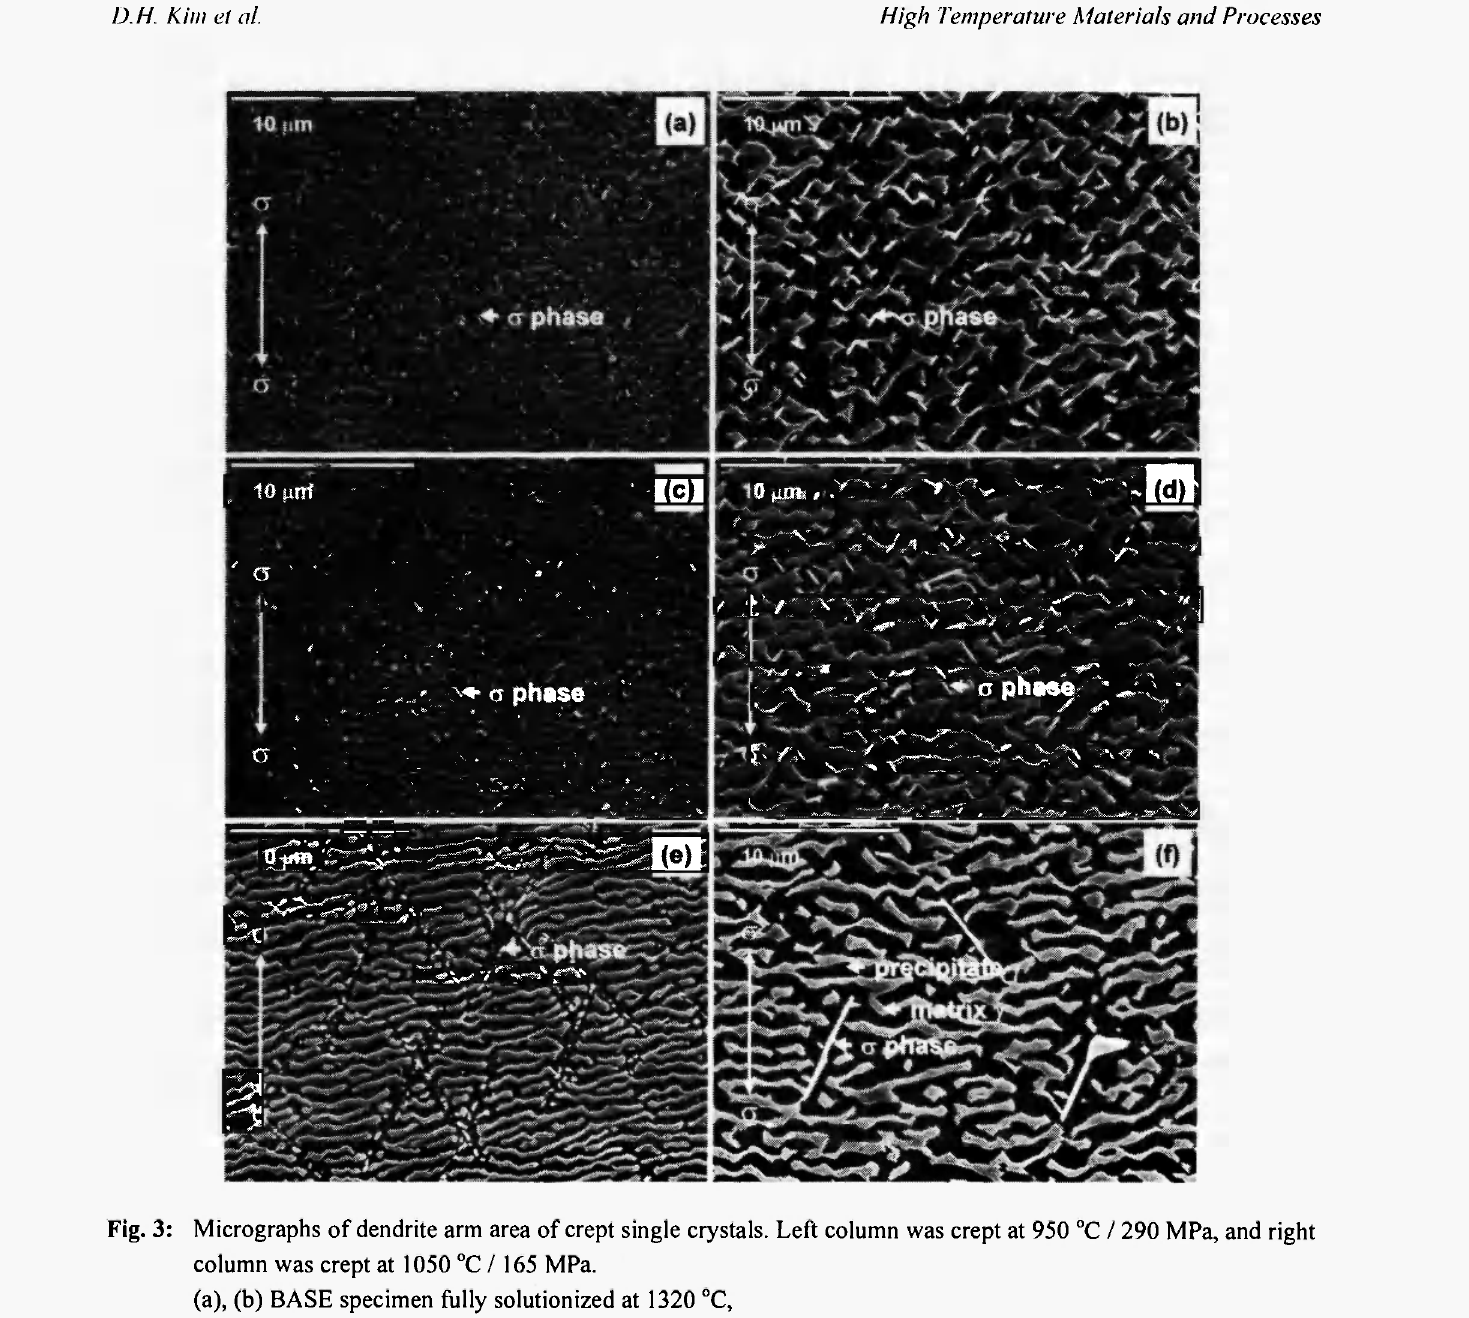
Fig. 3: Micrographs of dendrite arm area of crept single crystals. Left column was crept at 950 °C / 290 MPa, and right column was crept at 1050 °C /165